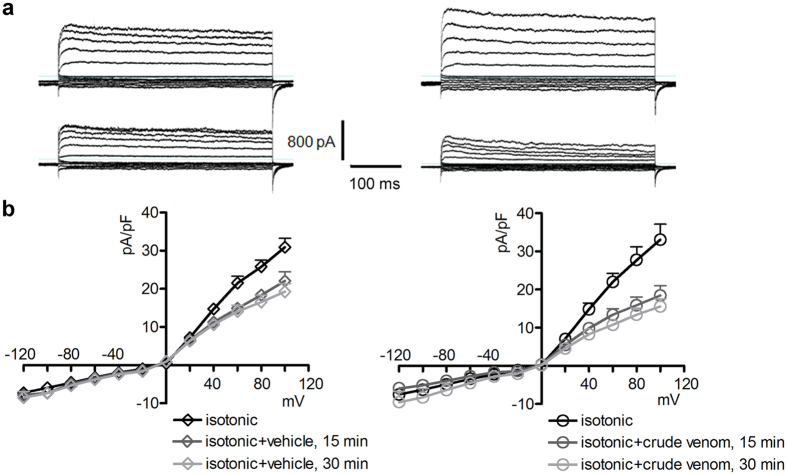
Crude venom does not modify the K+ conductance of HEK 293 Phoenix cells.(a) Original current recordings obtained in whole-cell configuration with pipette solution 2 (Table 2) and bath solution 3 (Table 1) before (top panels) and 15 min after (lower panels) addition of the vehicle (left panels) or 0.025 μg/μl crude venom (right panels) to the bath solution. (b) current density (pA/pF) to voltage (mV) relationship of K+ currents before, 15 and 30 min after addition of the vehicle (left; n = 14) or crude venom (right; n = 7) to the hypotonic solution. No significant differences in current intensity between vehicle or venom-treated cells were detected, unpaired Student’s t test.